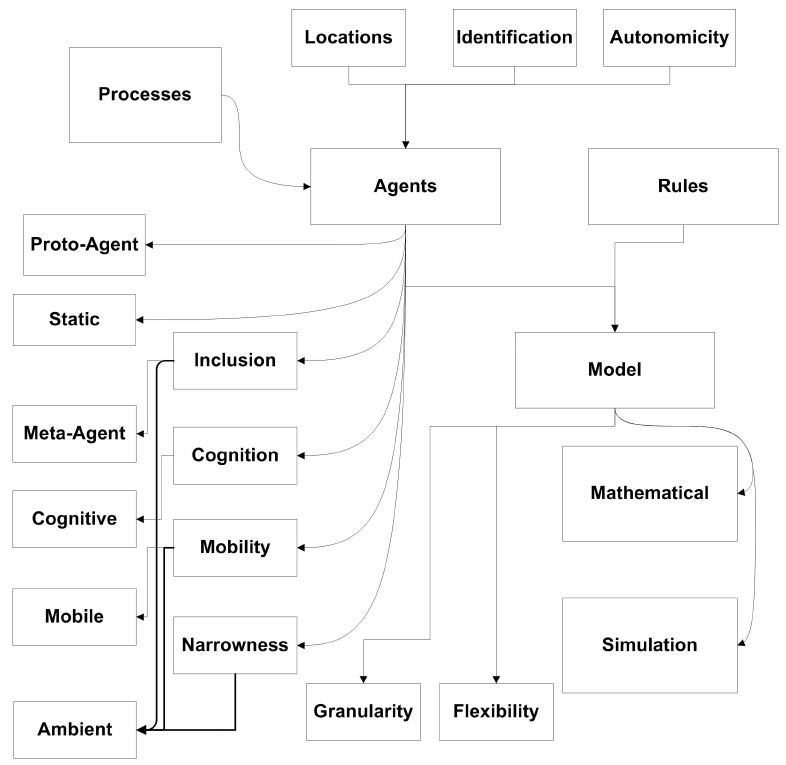
Figure 1. Meta-model of modeling by integrated use of ABM and